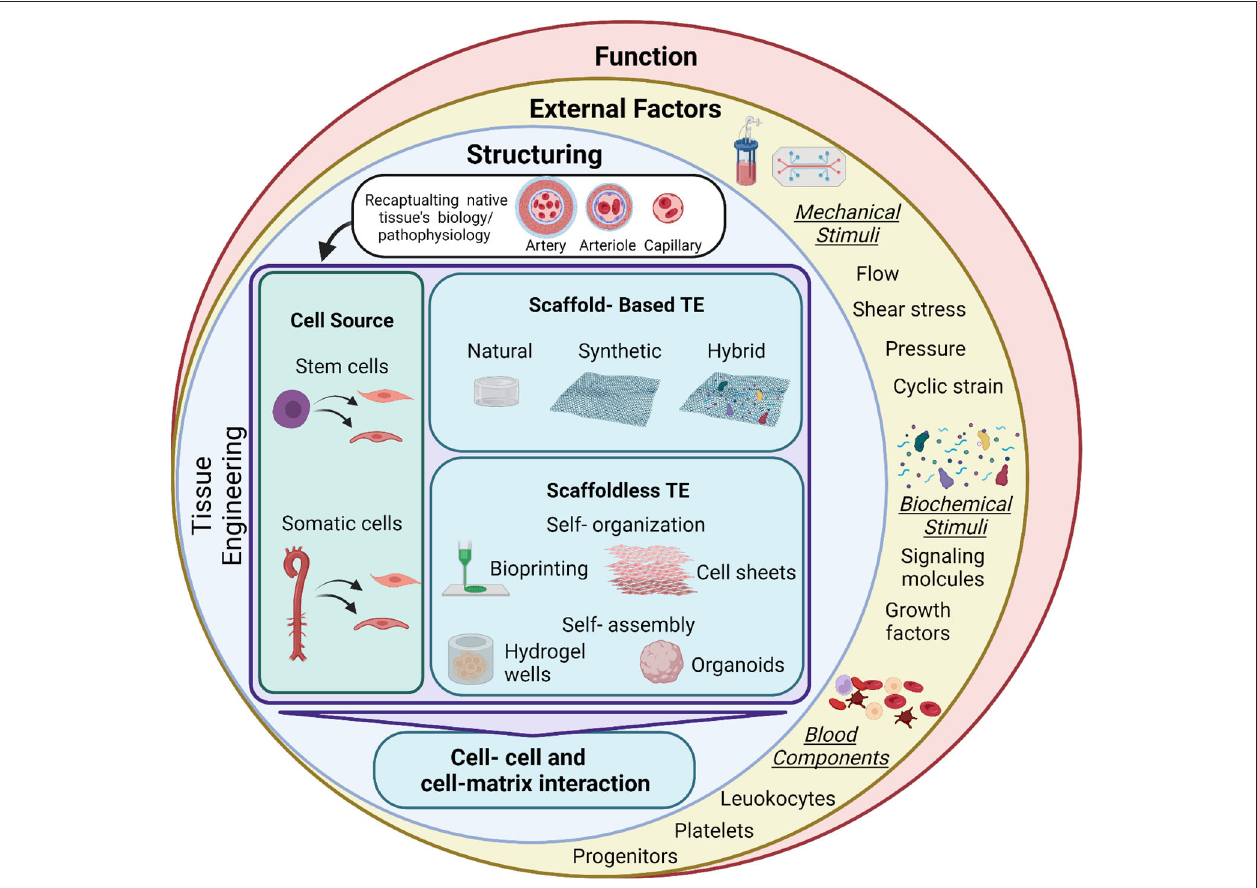
FIGURE 2 | Summary of tissue engineering approaches and applications for drug testing. Tissue engineering (TE) is used to develop vascular grafts of different sizes and structures to recapitulate the native biology/pathophysiology of the target tissue. Investigated cell sources are of somatic or stem cell origin. Vascular grafts are developed through either scaffold-based or scaffoldless TE approaches. Scaffold based approaches adopt the classical TE scheme and rely on the culture of cells on natural, synthetic or hybrid scaffolds to provide structural support and stability of the construct. Emerging scaffoldless techniques rely on self-organization or self-assembly of the cells and their ability to secrete extracellular matrix to develop the vascular tissue. Self-organization is achieved through bioprinting or cell sheet multi-layering techniques. Self-assembly is influenced in hydrogel wells to develop self-organized 3D tissues derived by the differential adhesion hypothesis. These TE techniques lead to the development of a 3D construct, characterized by cell-cell and cell-matrix interactions. This provides a better model for cells than the conventional 2D monolayer cultures that are currently used for drug screening. Exposing these constructs to external factors will increase the complexity of the system and provide a more accurate biomimetic substrate for drug testing. These factors include mechanical stimuli (fluid flow/shear, pressure, and cyclic strain), biochemical stimuli (signaling molecules and growth factors) and blood components (leukocytes, platelets, and progenitor cells). These factors will influence the function of the construct. Mimicking pathological conditions could also aid in modeling disease conditions, which will provide a more accurate representation for drug testing for specific pathologies. Figure was created by